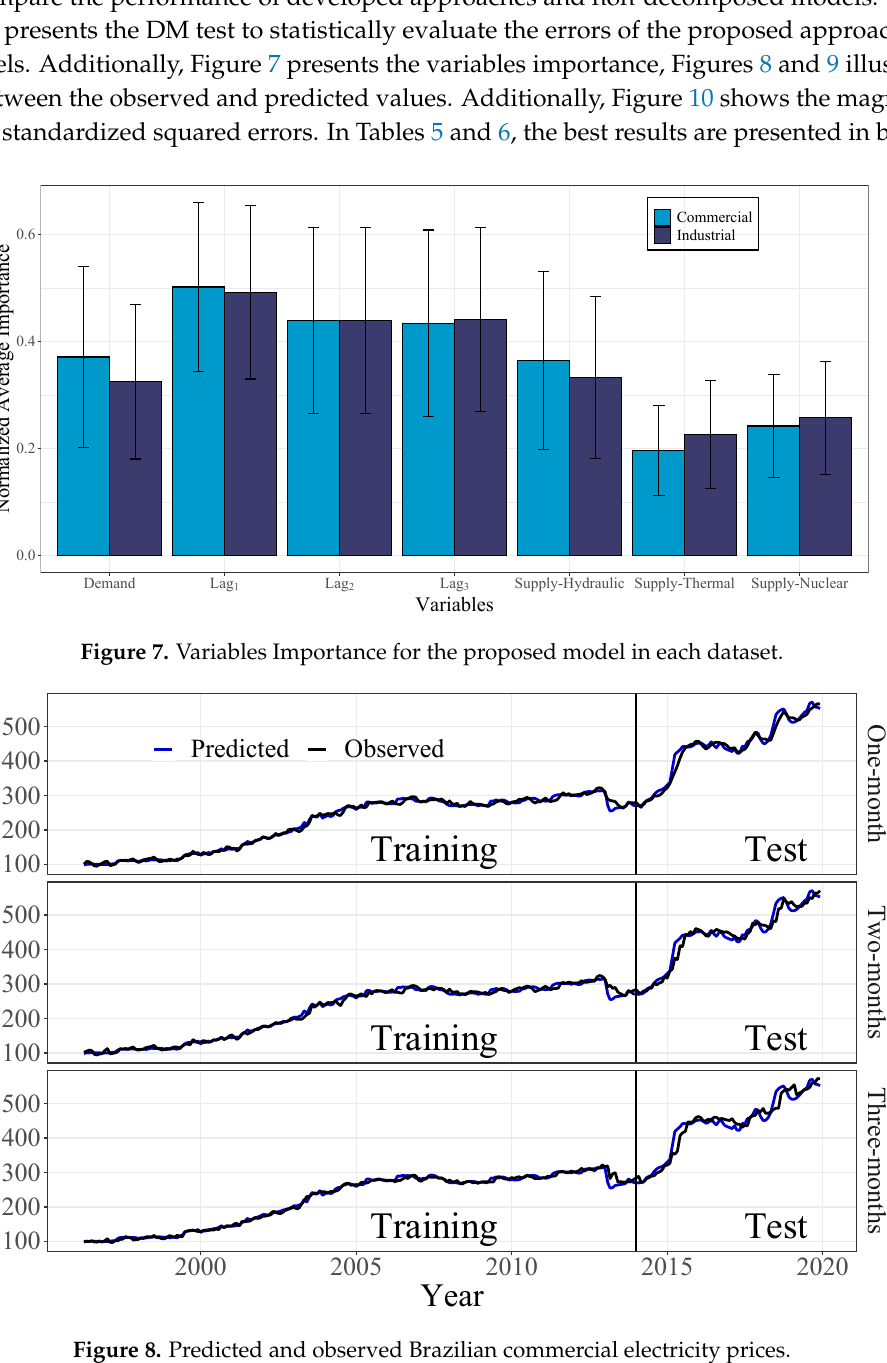
Figure 8. Predicted and observed Brazilian commercial electricity